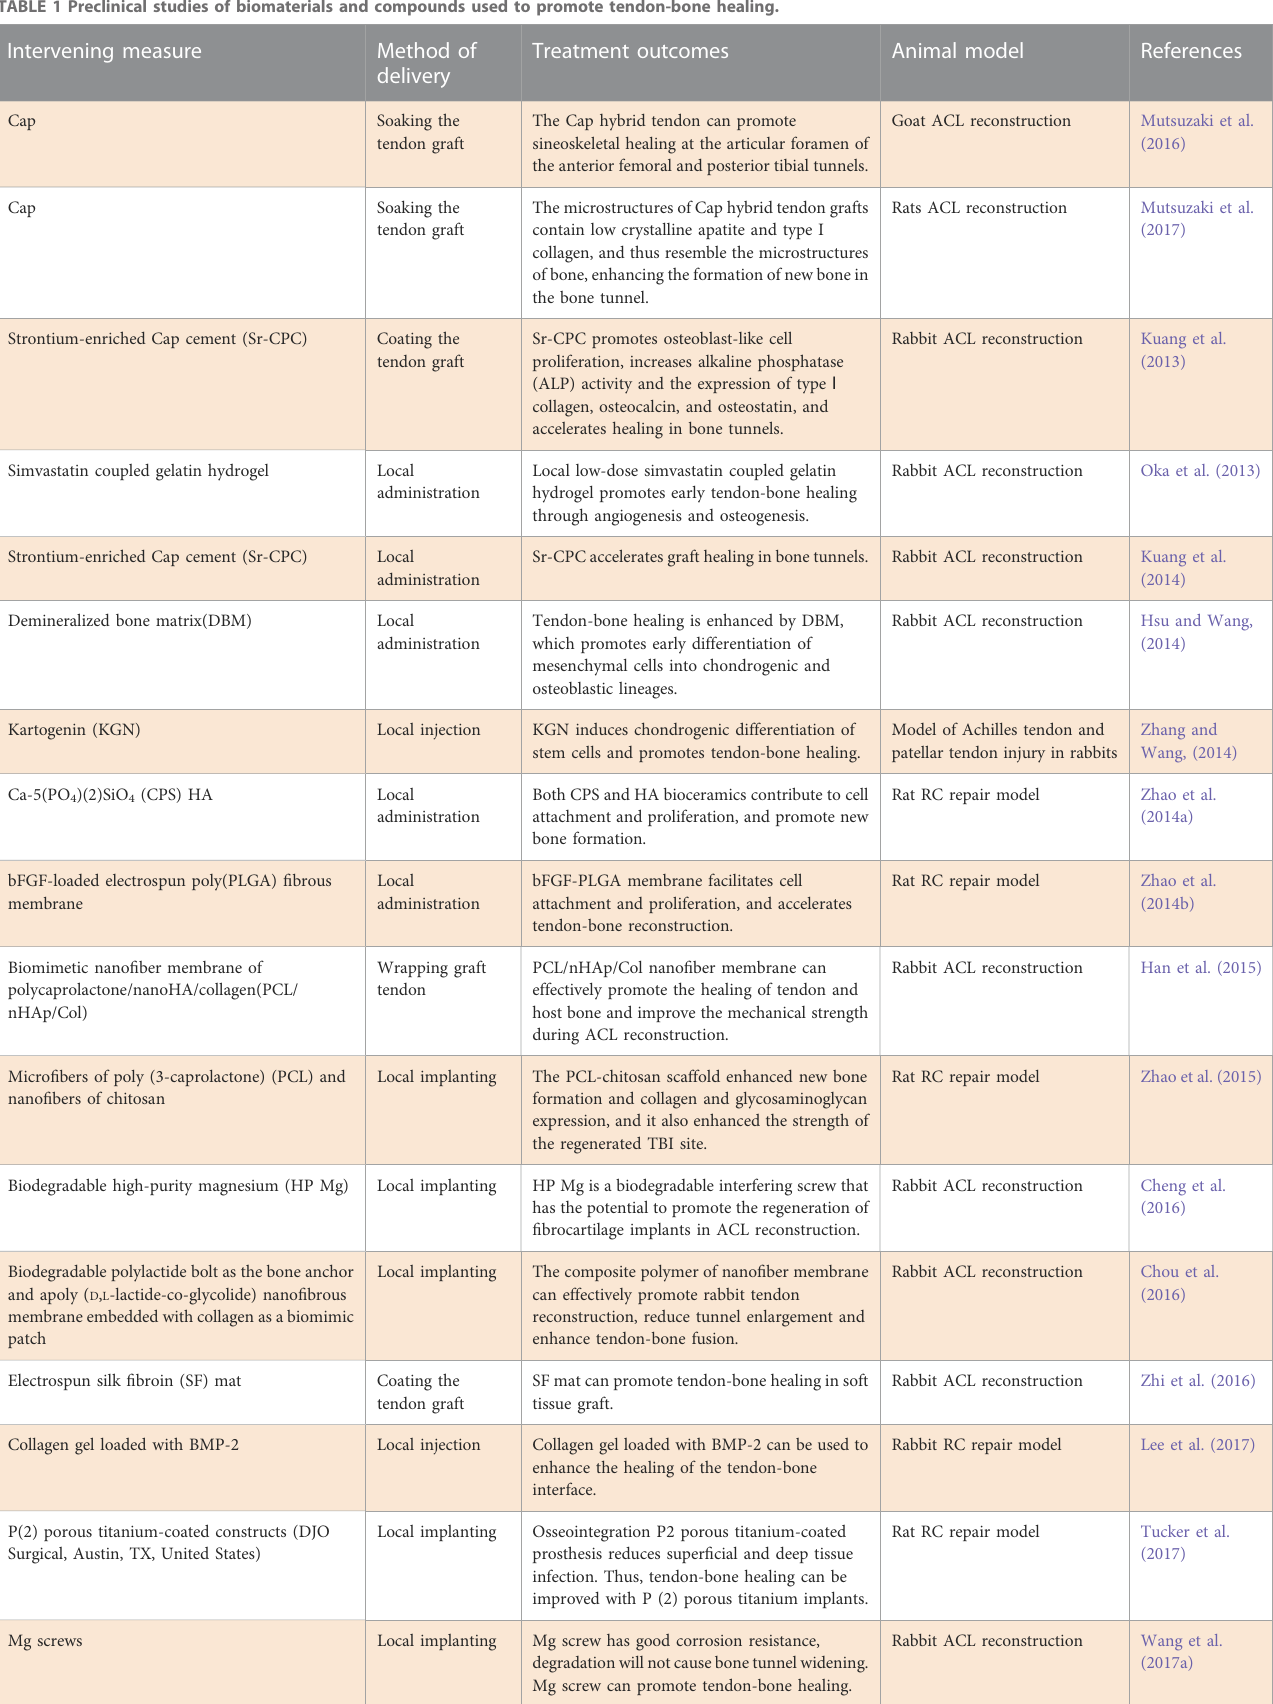
TABLE 1 Preclinical studies of biomaterials and compounds used to promote tendon-bone